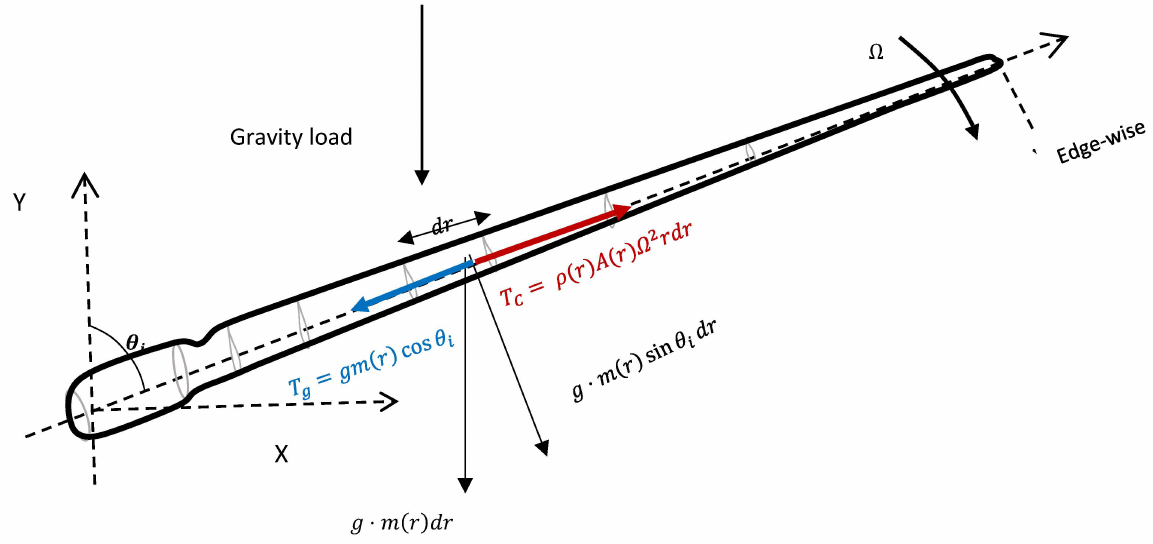
Figure 4. Gravitational load components acting on the blade in the edge-wise